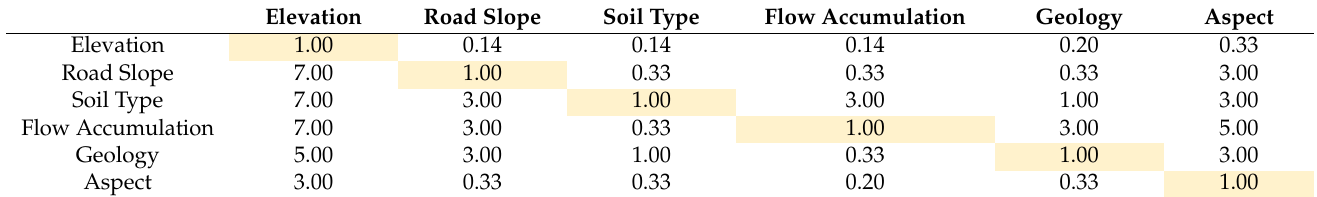
Table 2. Pair-wise comparison matrix and principal eigenvectors for road analysis applied in the AHP